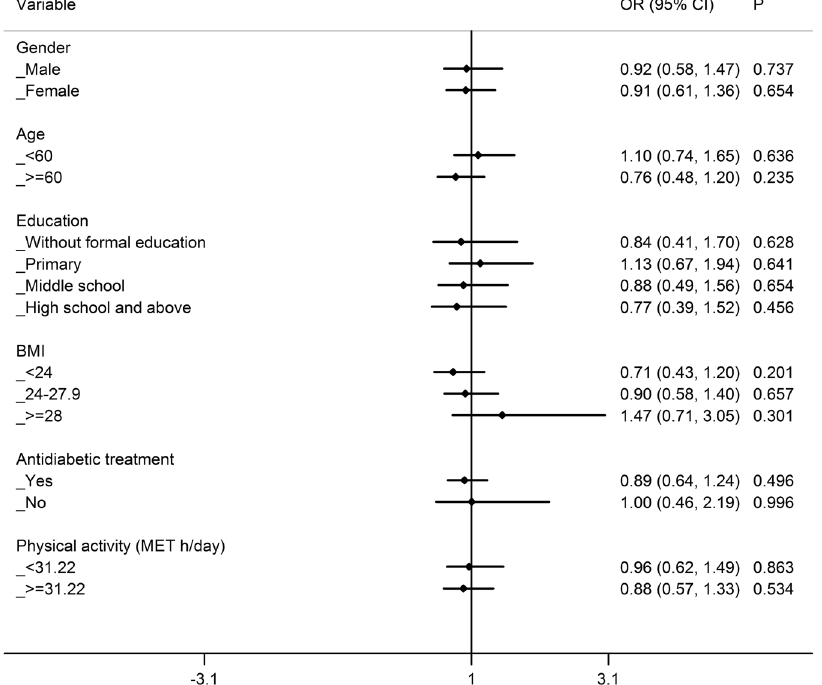
Figure 3. Stratified analyses of the comparison of poor glycaemic control between T2D patients with a paternal history of diabetes and patients without a FH of diabetes by age, gender, education, BMI, antidiabetic treatment and physical activity. Logistic regression was used to estimate the OR (95%CI) and each stratified analysis was adjusted for age, gender, education, BMI, antidiabetic treatment, physical activity, smoking, drinking, spouse with diabetes and duration of diabetes except the corresponding stratification factor. OR: odds ratio; CI: confidence